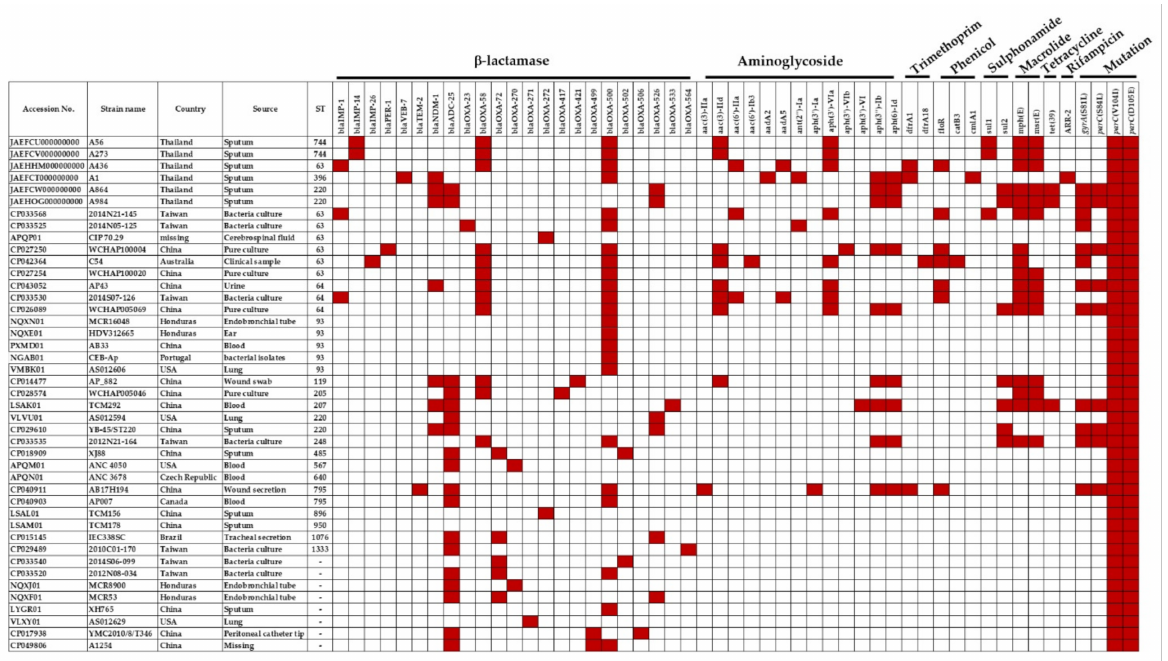
Figure 2. Genomic characterization of antibiotic-resistant genes in carbapenem-resistant A. pittii. The present of antimicrobial resistance genes is represented in red